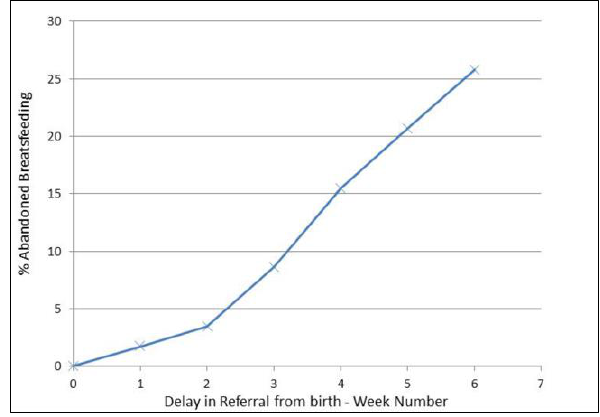
Figure 1: Proportion of babies abandoning breastfeeding by time of delay to clinic